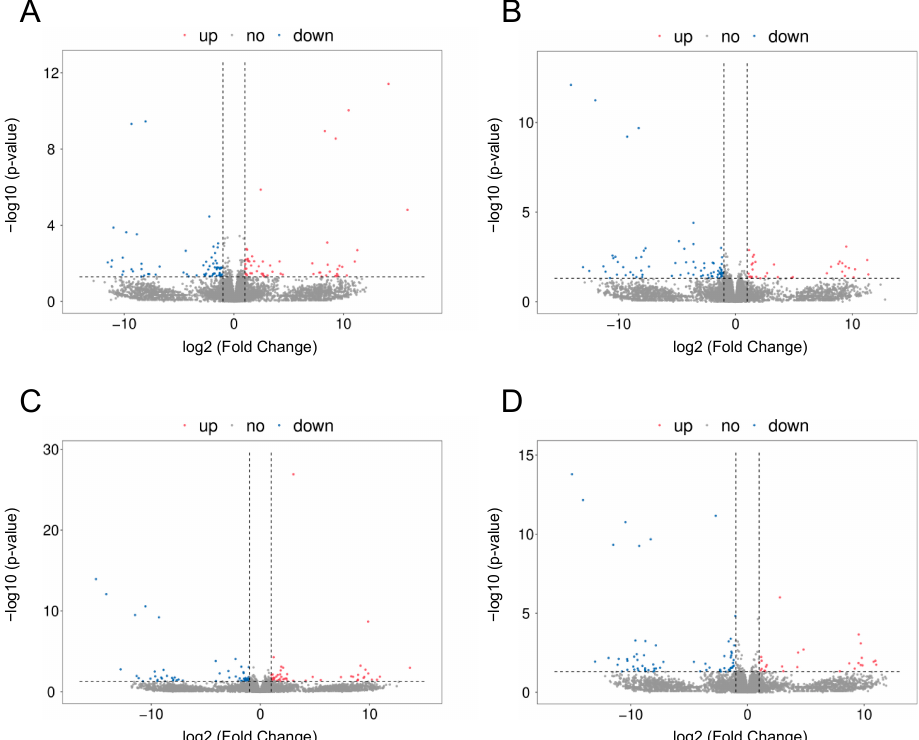
Figure 2. Volcano plots describing the abundance of transcript expression profiles after LPS ( A ); or LPS in combination with: GW0724 at a concentration of 1 μ mol/L ( B ), GW0724 at a concentration of 10 μ mol/L ( C ), and GSK3787 ( D ) treatment in mid-luteal phase in the corpus luteum. Logarithmic fold changes in expression (log 2 FC) are plotted on the x -axis against normalized adjusted p -values ( y -axis). The sharp horizontal line denotes the negative logarithmic adjusted p -value (0.05) cut-off. Sharp vertical lines denote the fold change cut-off (absolute value of log 2 FC > 1). Points represent gene expression values, where blue (underexpressed) and red (overexpressed) points denote significant genes (adjusted p -value < 0.05). Grey dots indicate non-significant